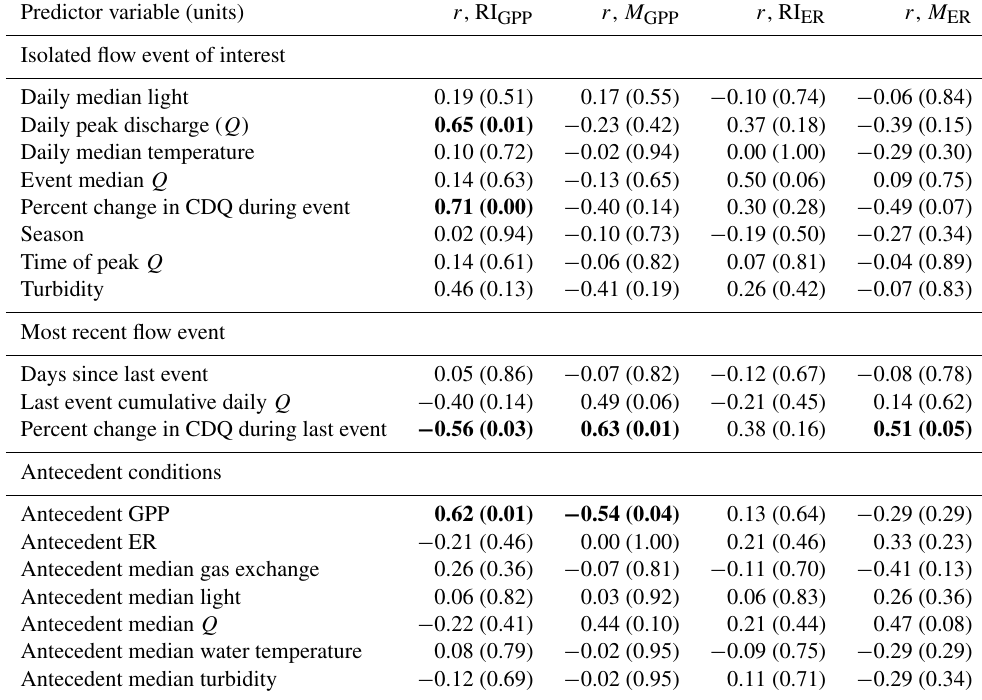
Table 4. Pearson correlations ( r ) between predicted drivers of gross primary production (GPP) and ecosystem respiration (ER) magnitudes of departure ( M ) and recovery intervals (RIs) of isolated flow events. Predictor variables with moderate or stronger relationships ( r > 0 . 5; Hinkle et al., 2003) are bolded. The p values are included in parentheses. CDQ = cumulative daily